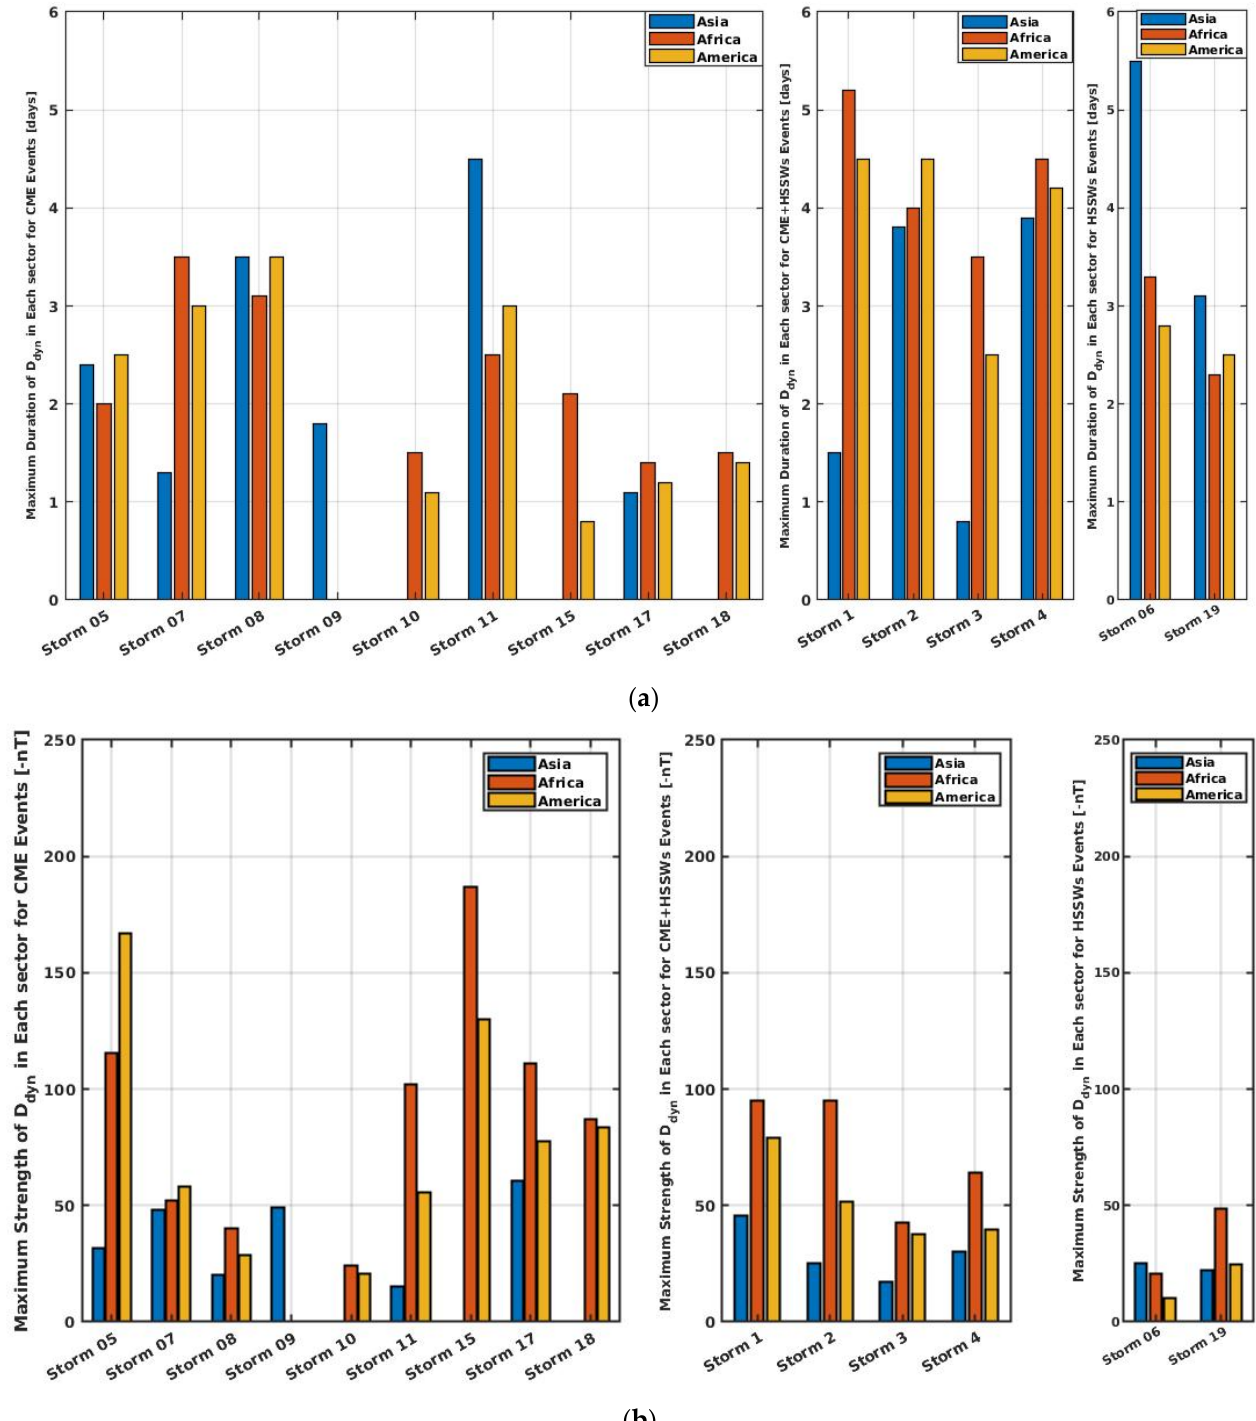
Figure 8. ( a ) Maximum duration of D dyn during each of the selected storm: (from left to right) CME, CME + HSSW, and HSSW events. ( b ) Maximum strength of D dyn observed each of the selected storm: (from left to right) CME, CME + HSSW, and HSSW events.